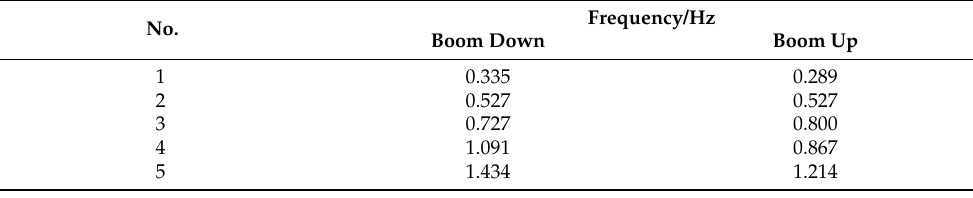
Table 8. The first five natural frequencies of the quayside container crane models.